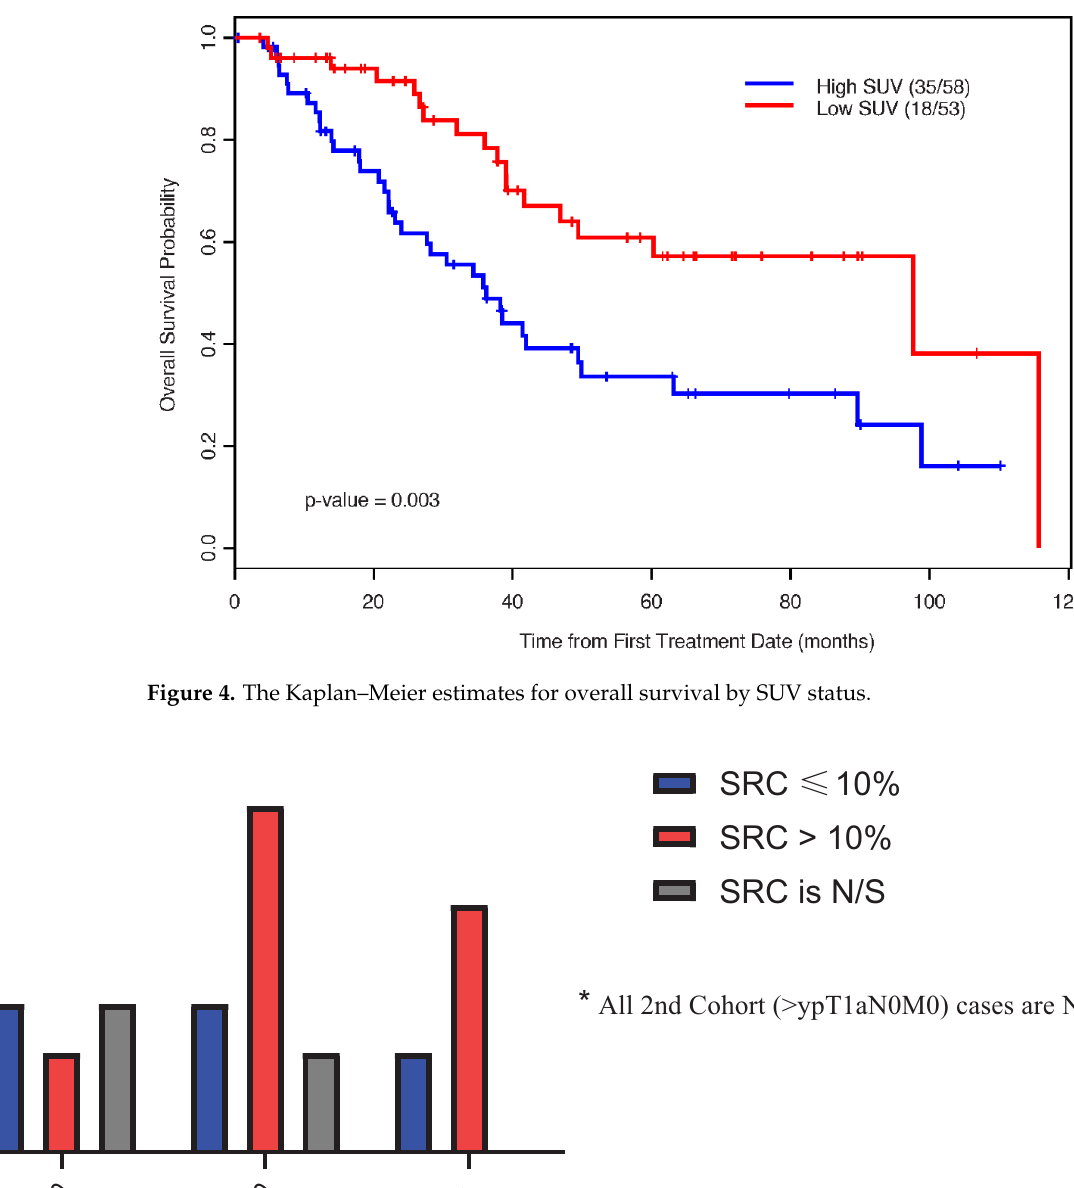
Figure 5. Post treatment signet ring cells (SRC) percentage distribution in Low-SUV group.